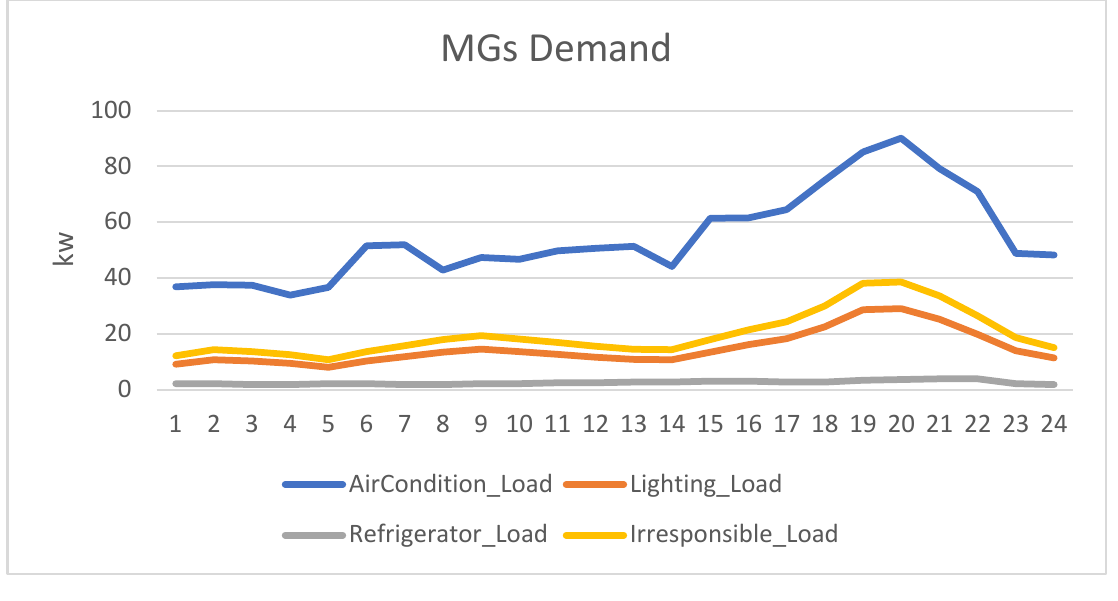
Figure 4. Consumption of consumers in each microgrid.